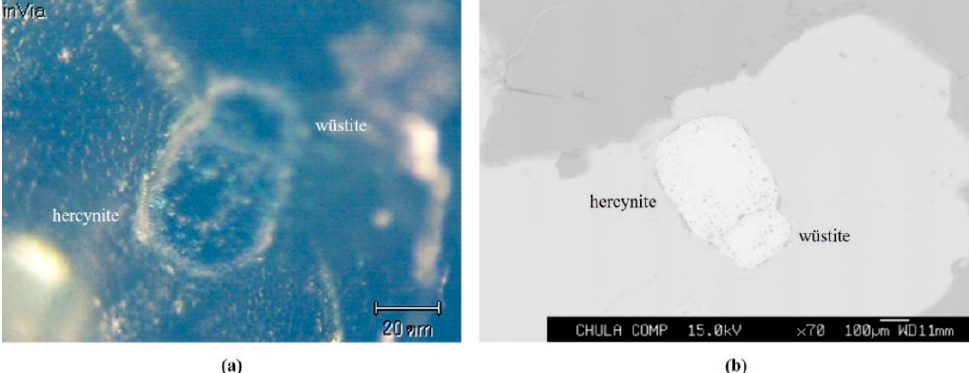
Figure 5. ( a ) Photomicrographs and ( b ) black-scattered electron images (BSIs) showing hercynite–wüstite compositee inclusion found in sapphire (sample PT55) from Binh Thuan.